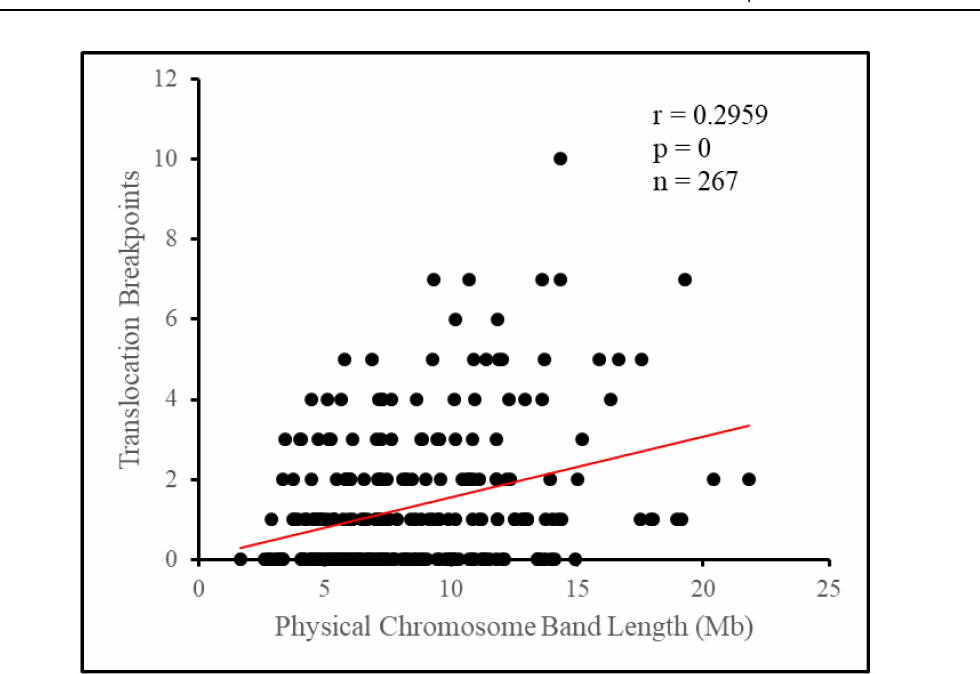
Figure 4. Physical cytogenetic band length is associated with the number of translocation breakpoints. (a) Scatterplot comparing the number of breakpoints to the physical length of each cytogenetic band. Spearman’s correlation coe ffi cient was used to determine if there is a relationship between the two variables. r = Spearman’s correlation coe ffi cient and p = numerical representation that the result was seen by